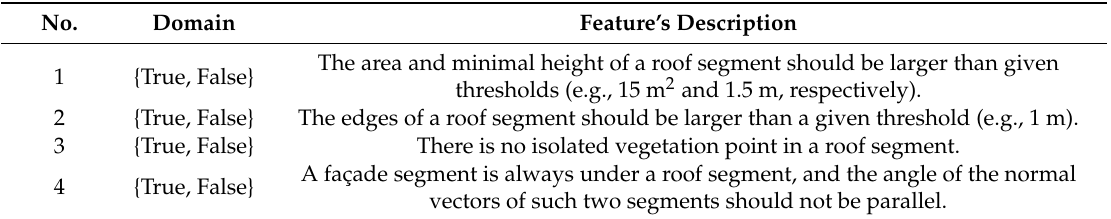
Table 3. Heuristic rule-based features